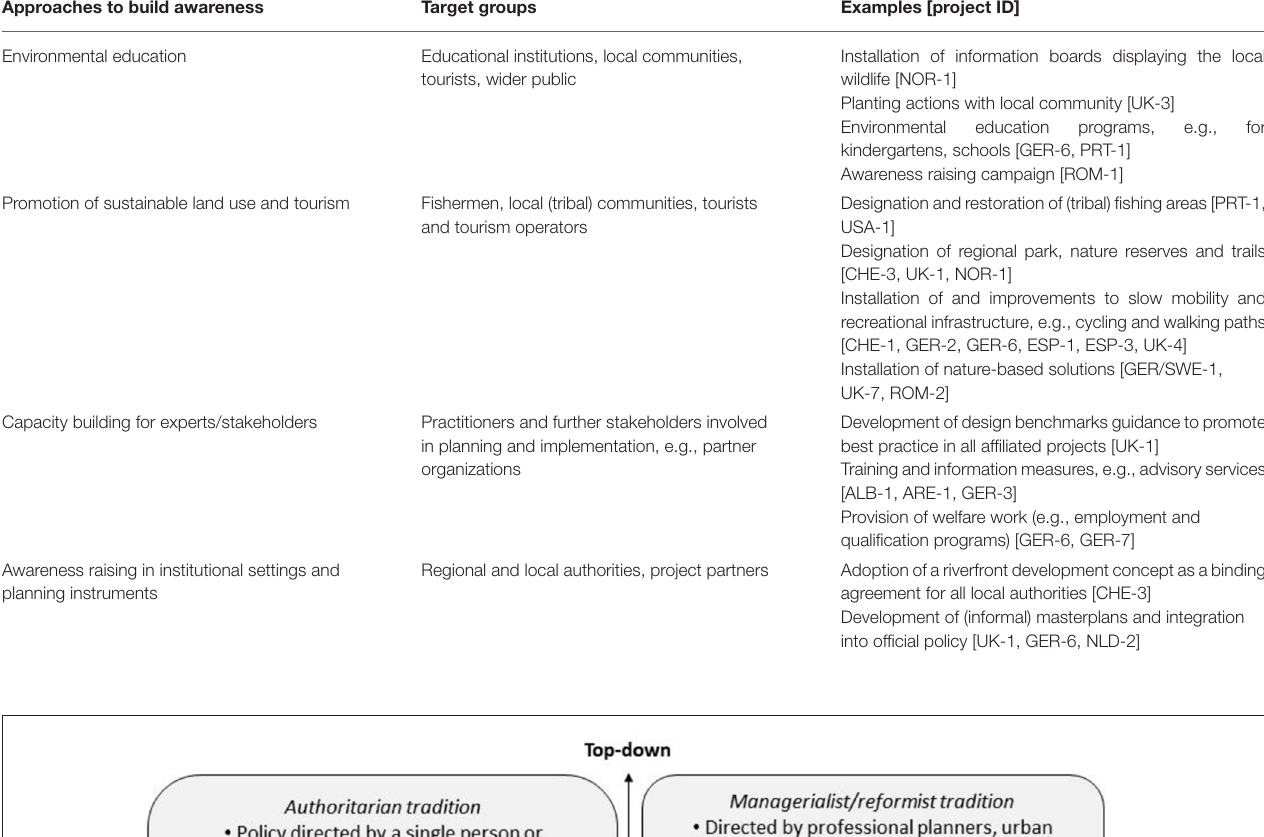
TABLE 2 | Tools to building awareness among project stakeholders [modified from (13)].